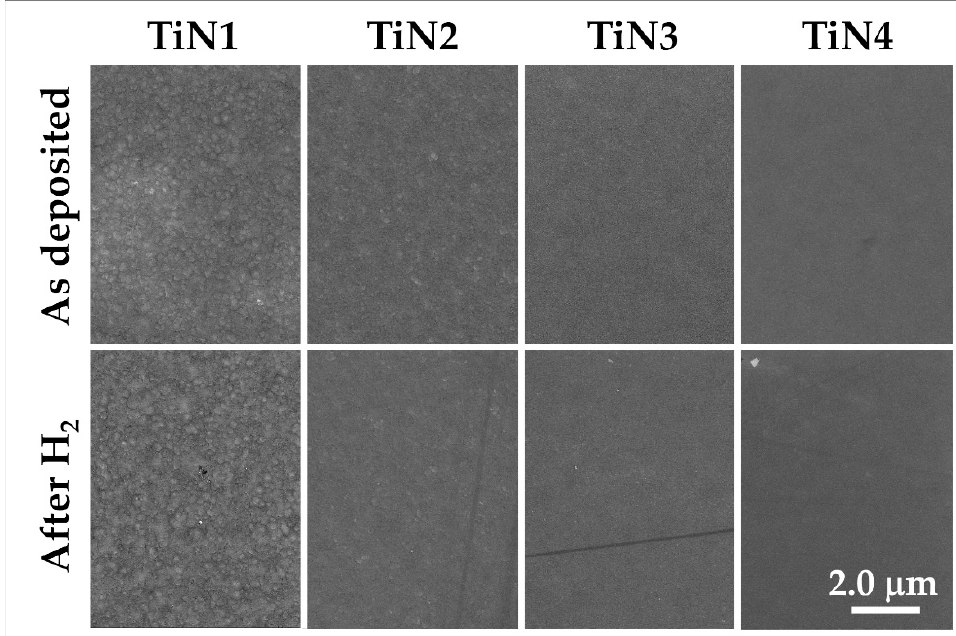
Figure 8. SEM micrographs of samples TiN1, TiN2, TiN3, TiN4 after thermal treatment at 500 °C under H 2 -containig atmosphere for 20 h.